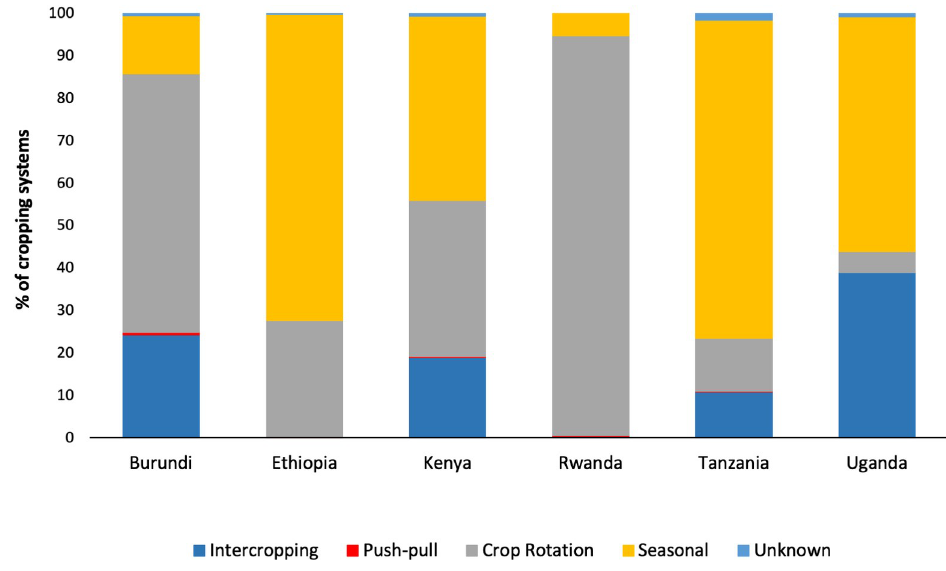
Fig 4. Proportion of different cropping systems in East Africa.